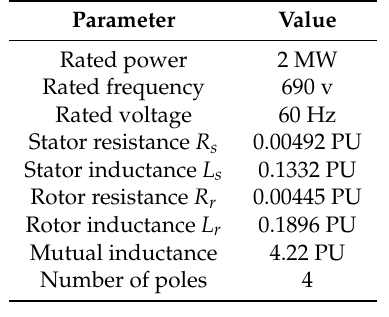
Table 1. Squirrel cage induction generator (SCIG) wind turbine data.